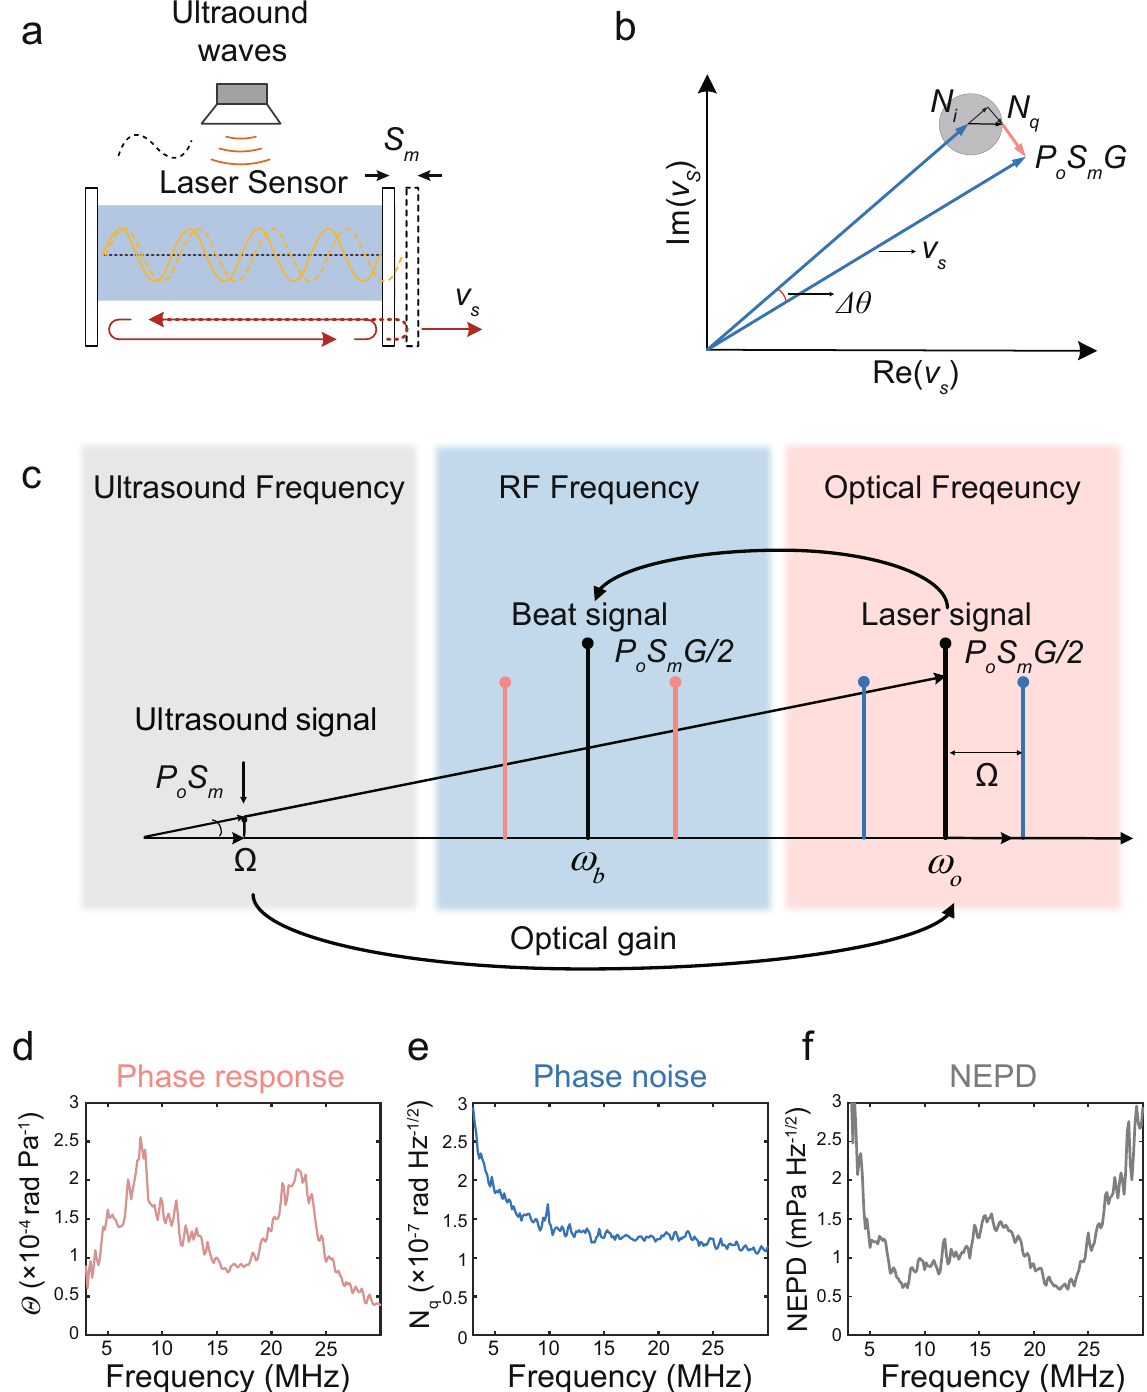
Fig. 1 | Working principle and characterization of the laser-based ultrasound sensor. a Schematic of the laser sensor. Ultrasound waves modulate the sensor geometrywith a coef fi cient S m . b Vector diagram for measurement of the signal v s with an acoustically induced phase modulation Δ θ . The noise (gray shading) is decomposedintothein-phasecomponent N i andquadrature-phasecomponent N q